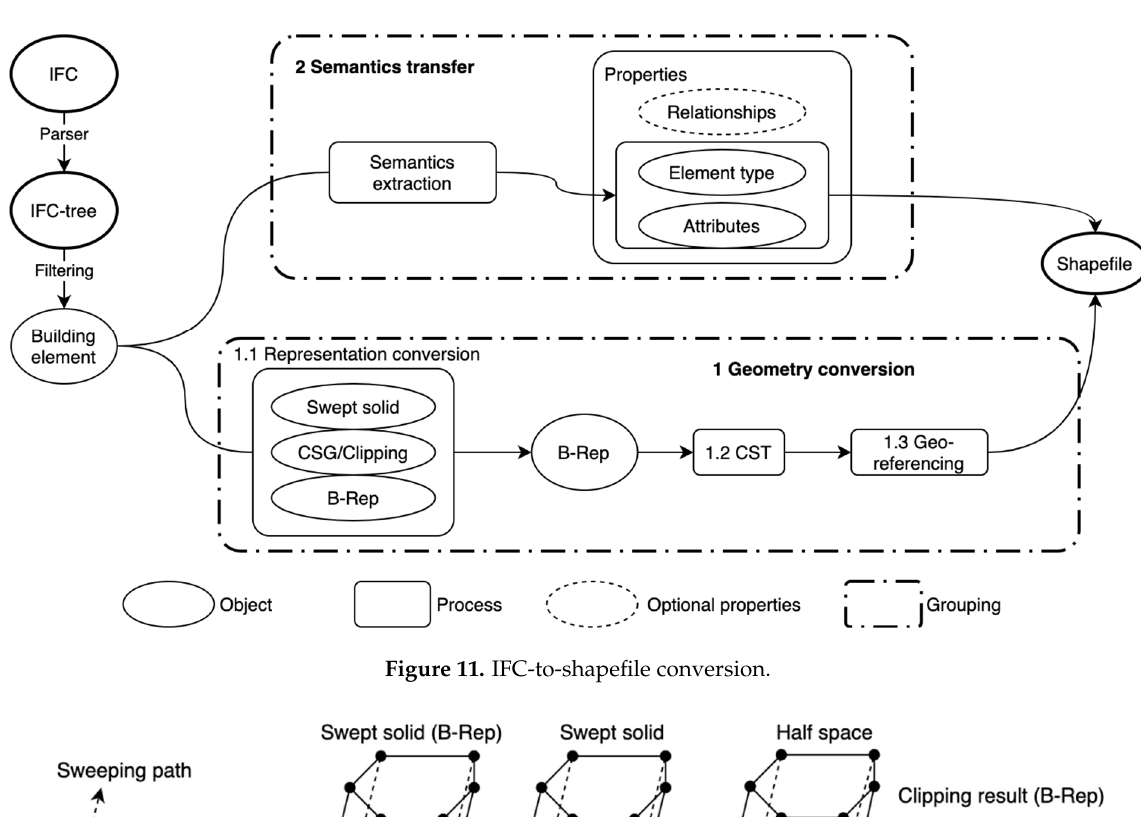
Figure 11. IFC-to-shapefile conversion.